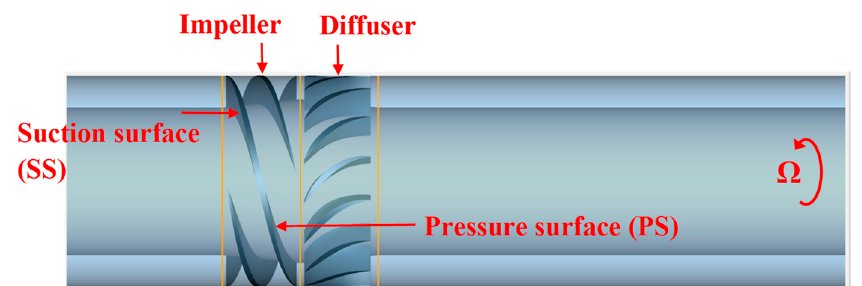
Figure 1. Three ‐ dimensional model of HAMP ( Ω denotes rotational direction). Figure 1. Three-dimensional model of HAMP ( Ω denotes rotational